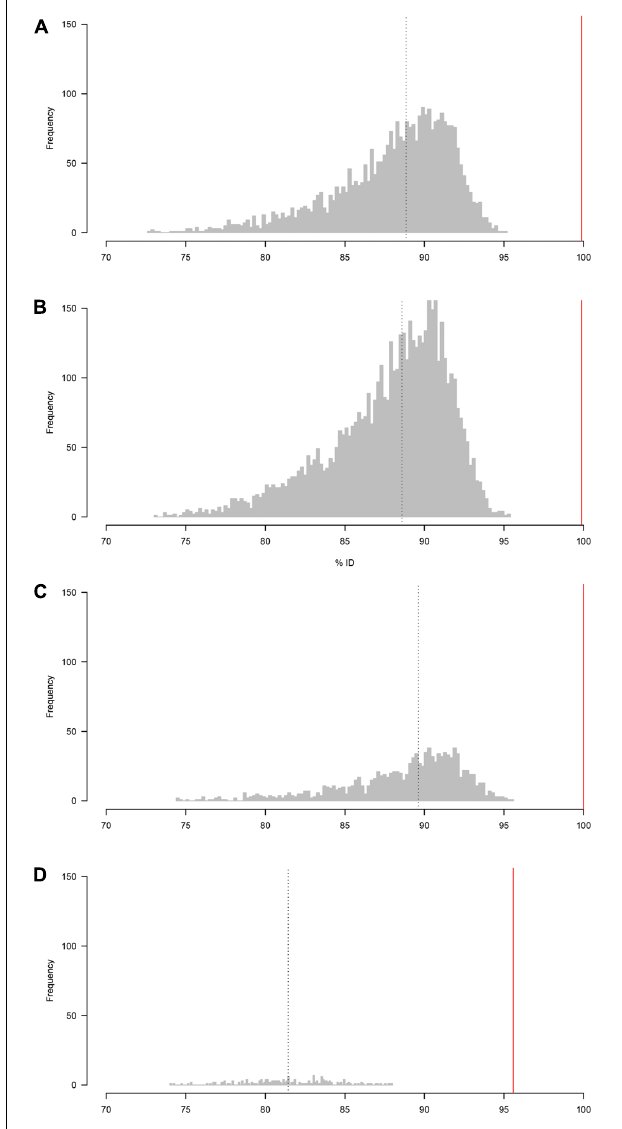
FIGURE 1 | Distribution of percentage sequence identity between raw reads and the (Sanger) reference sequence (A) A. simplex , (B) P. redivivus , (C) T. aceti , and (D) C. elegans . (A–C) were run on a new MinION flow cell, whereas (D) was run on a flow cell that had been used twice before (for a total of 26.5 h, see main text for more details). The median percent identity (indicated by a vertical dotted line) is 88.5% for A. simplex , 87.7% for P. redivivus , 89.5% for T. aceti and 82.3% for C. elegans . Bioinformatic analyses using the ONTrack pipeline generated a consensus sequence for every sample that had a 99.9% (A,B) , 100% (C) , and 95.6% (D) accuracy compared to their Sanger reads (indicated by a vertical red line).